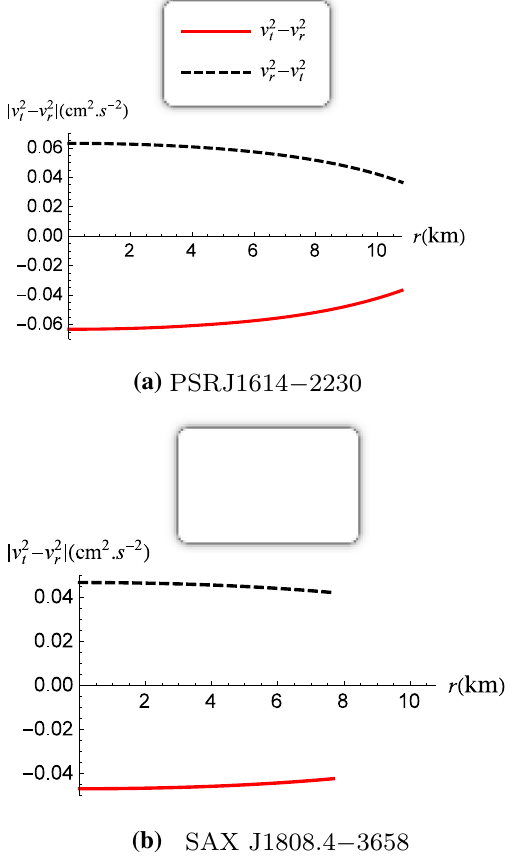
Fig. 9 Variation of the quantity | v r 2 − v t 2 | verses the radius